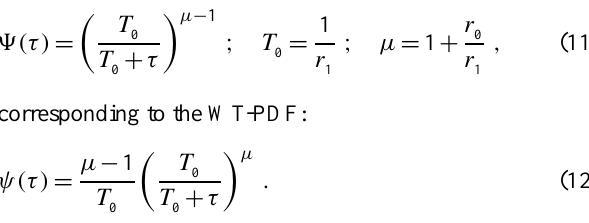
through the box F = 0